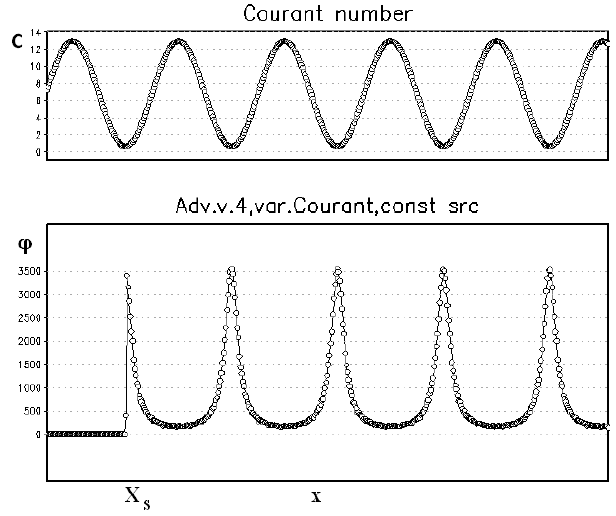
Figure 5. Linear-motion tests with a constant-release point source at X s and varying wind speed along the x axis. Upper panel: Courant number; lower panel: concentration (arbitrary unit). Wind blows from left to right. Without